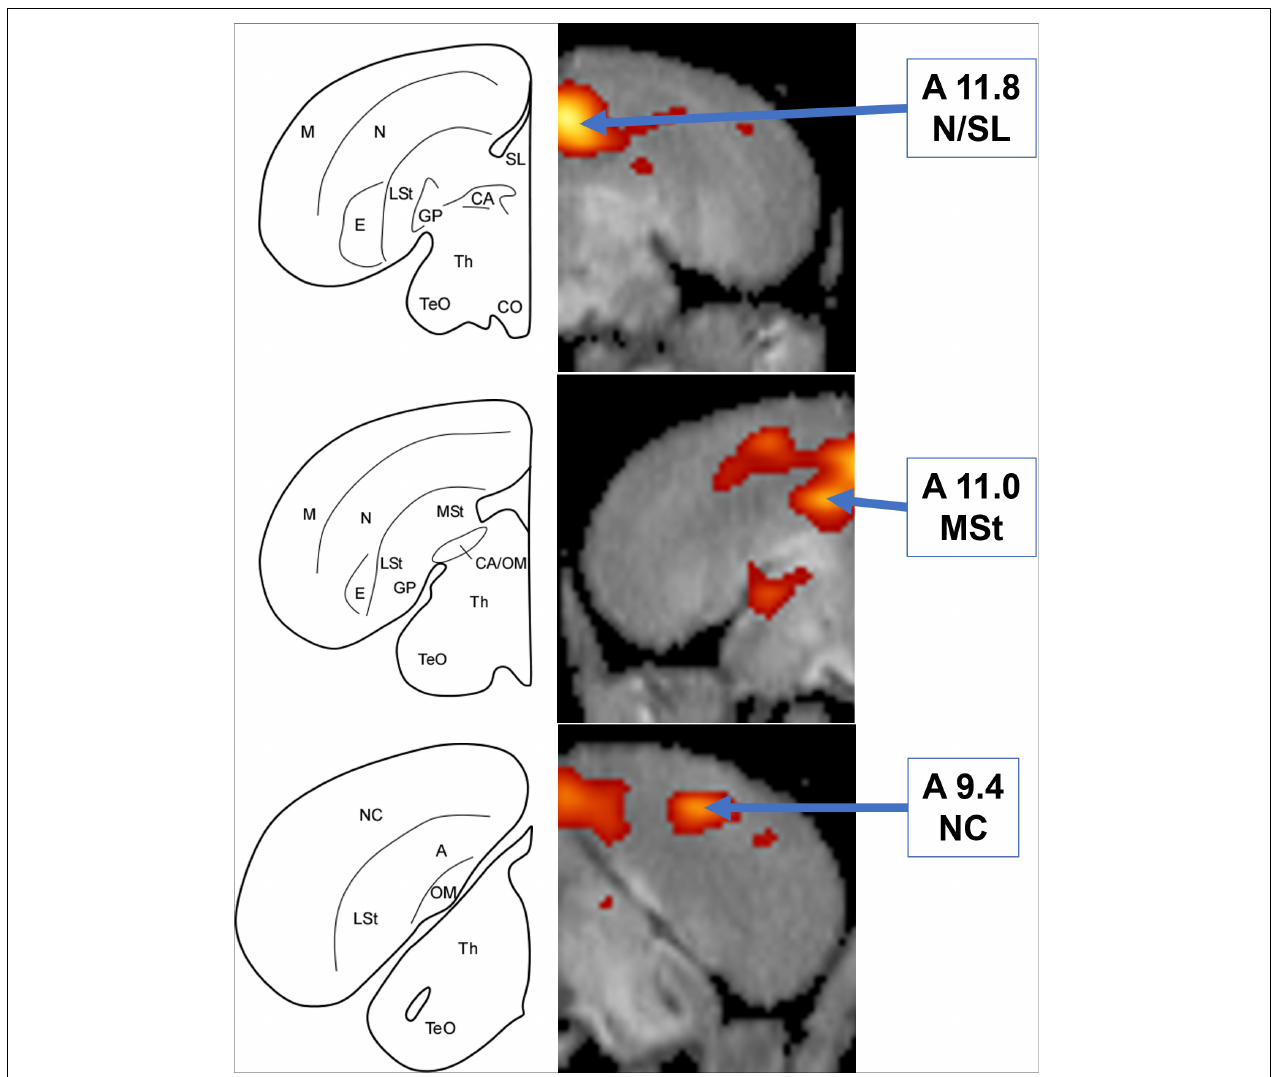
FIGURE 3 | Left: Schematic coronal hemisections of the American crow brain, drawn based on structural MRI of the American crow brain and Izawa and Watanabe jungle crow atlas. A, Arcopallium; CA, Anterior Commissure; CO, Optic Chiasm; E, Entopallium; GP, Globus Pallidus; LSt, Lateral Striatum; M, Mesopallium; MSt, Medial Striatum; N, Nidopallium; NC, Caudal Nidopallium; OM, Occipito-mesencephalic Tract; SL, Lateral Septum; TeO, Optic Tectum; Th, Thalamus. Right: Coronal view of voxel-wise subtractions (converted to Z-scores) showing differential brain activity at the indicated region for all crows exposed to the audio stimulus ( n = 5). Brain activity is superimposed atop a composite ( n = 4) structural MRI of the American crow